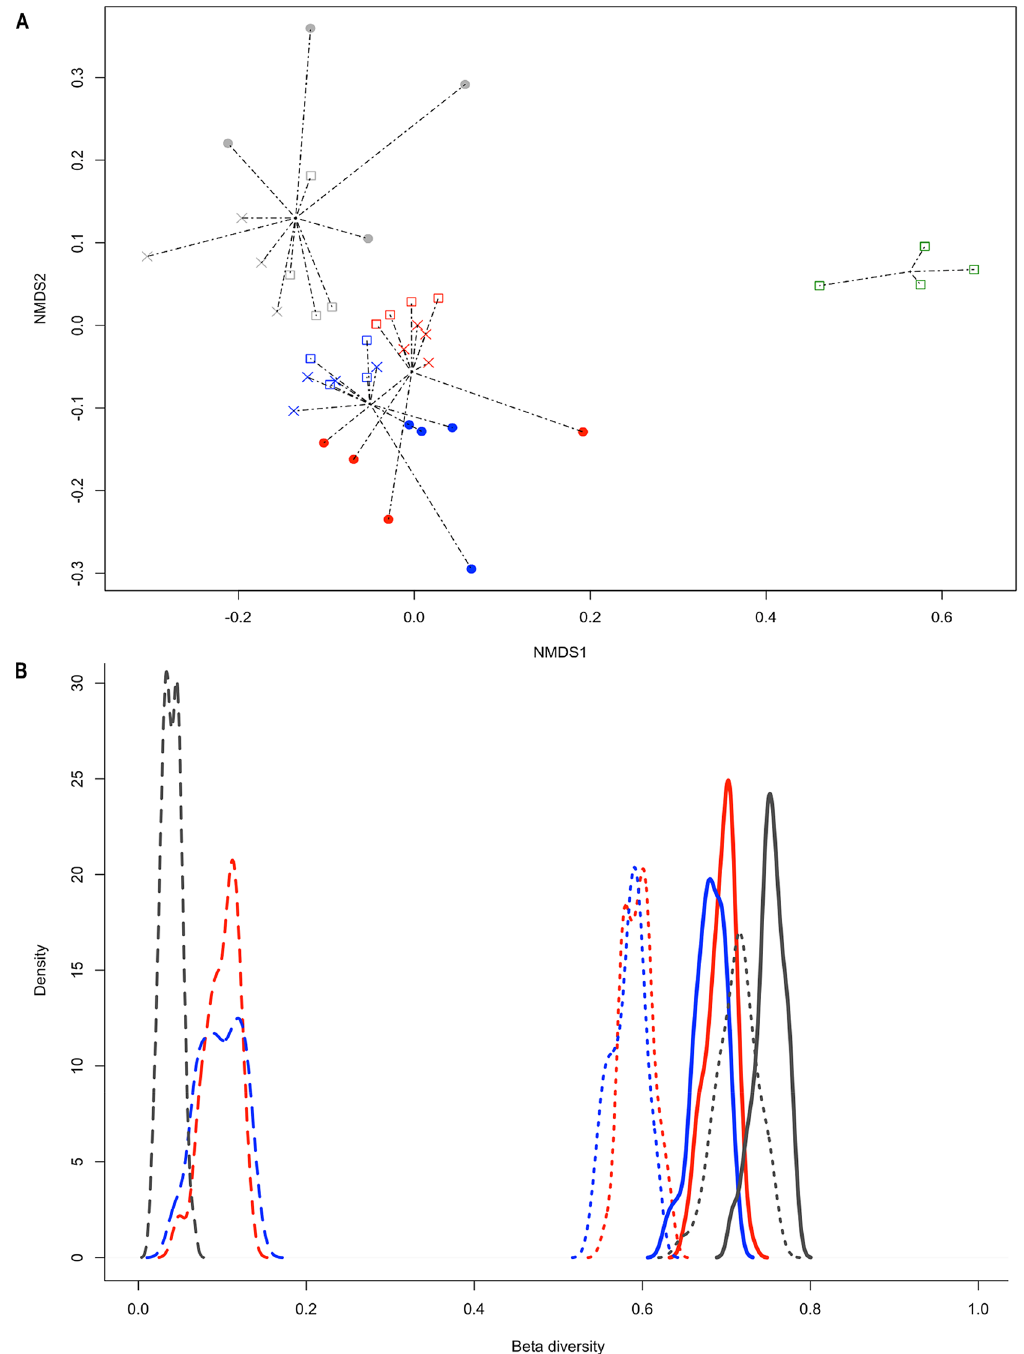
Figure 3. Beta diversity analyses of microbial meta-community of the non-rhizosphere, the rhizosphere and rhizoplane of Baccharis linearis plants inhabiting abandoned tailings and surrounding soil. (A) Non-metric multidimensional scaling analysis of meta-community dissimilarities. Grouping by localization and root compartments was performed by estimation of the total beta diversity distances (β SOR ) between samples. The localization and root compartment are denoted as follows: Huana tailings (blue), Tambillos tailings (dark grey), fresh tailings (green), surrounding soil (red), rhizoplane (filled circle), rhizosphere (x) and non-rhizosphere ( □ ). Each point corresponds to a single T-RFLP profile (n = 4 replicates). (B) Density plots representing the distribution of the total beta diversity (β SOR ), turnover (β SIM ) and nestedness (β SNE ) arising from multiple- site dissimilarity across the samples. Components of multiple-site dissimilarity were computed for microbial community composition (bacteria and fungi) in Huana (blue), and Tambillos (black) tailings and surrounding soil (red). Β SNE : dashed line; β SIM : dotted line and β SOR : solid line. These figures were created using Betapart R Package Version 1.3. URL http:// CRAN.R- proje ct. org/ packa ge= betap